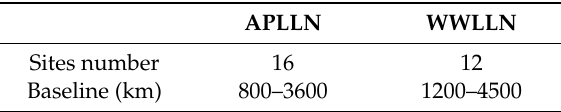
Table 4. The number of sites and the baseline of APLLN and WWLLN in the surrounding areas of